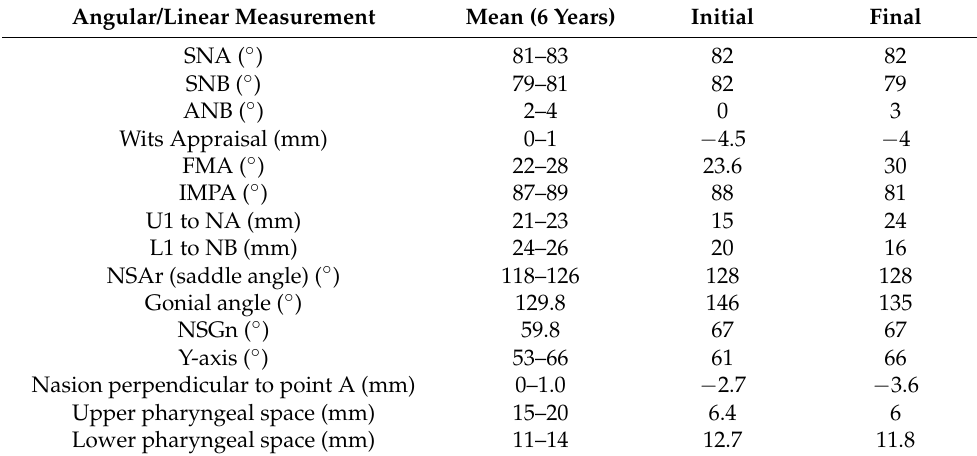
Figure 3. Pre ‐ treatment and post ‐ treatment extraoral and intraoral photographs. Figure 3. Pre-treatment and post-treatment extraoral and intraoral photographs. Table 1. The pre-treatment and post-treatment lateral cephalometric